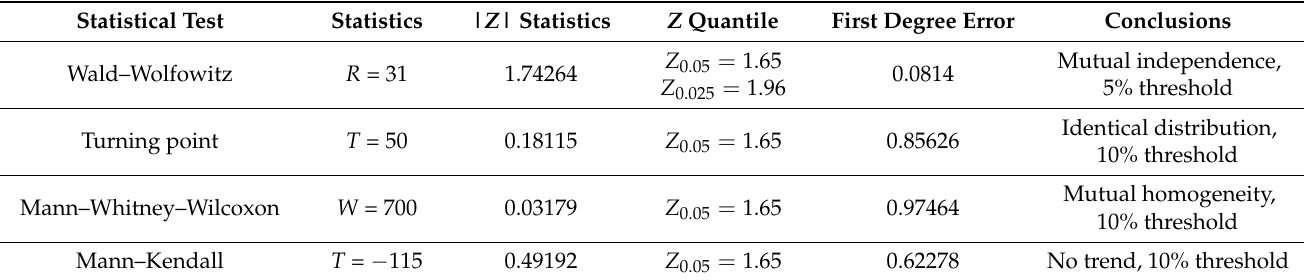
Table 1. Results of the statistical tests.